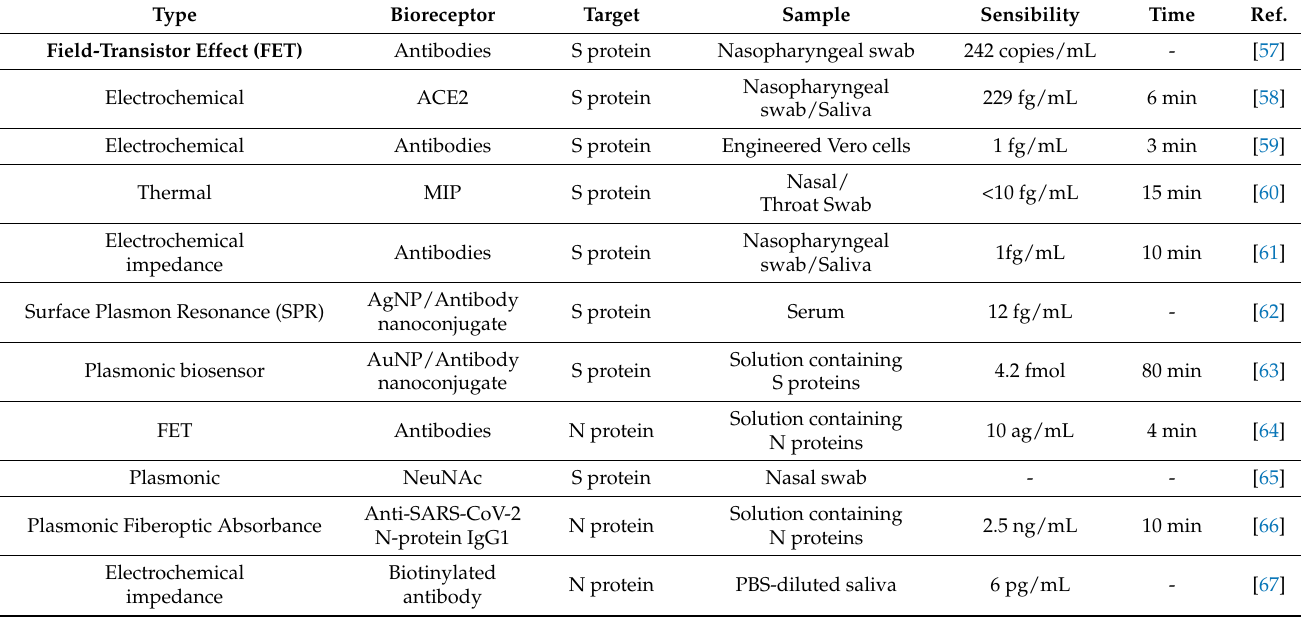
Table 2. Potentially useful biosensing methods targeting SARS-CoV-2 viral proteins (NeuNAc—N- acetyl neuraminic